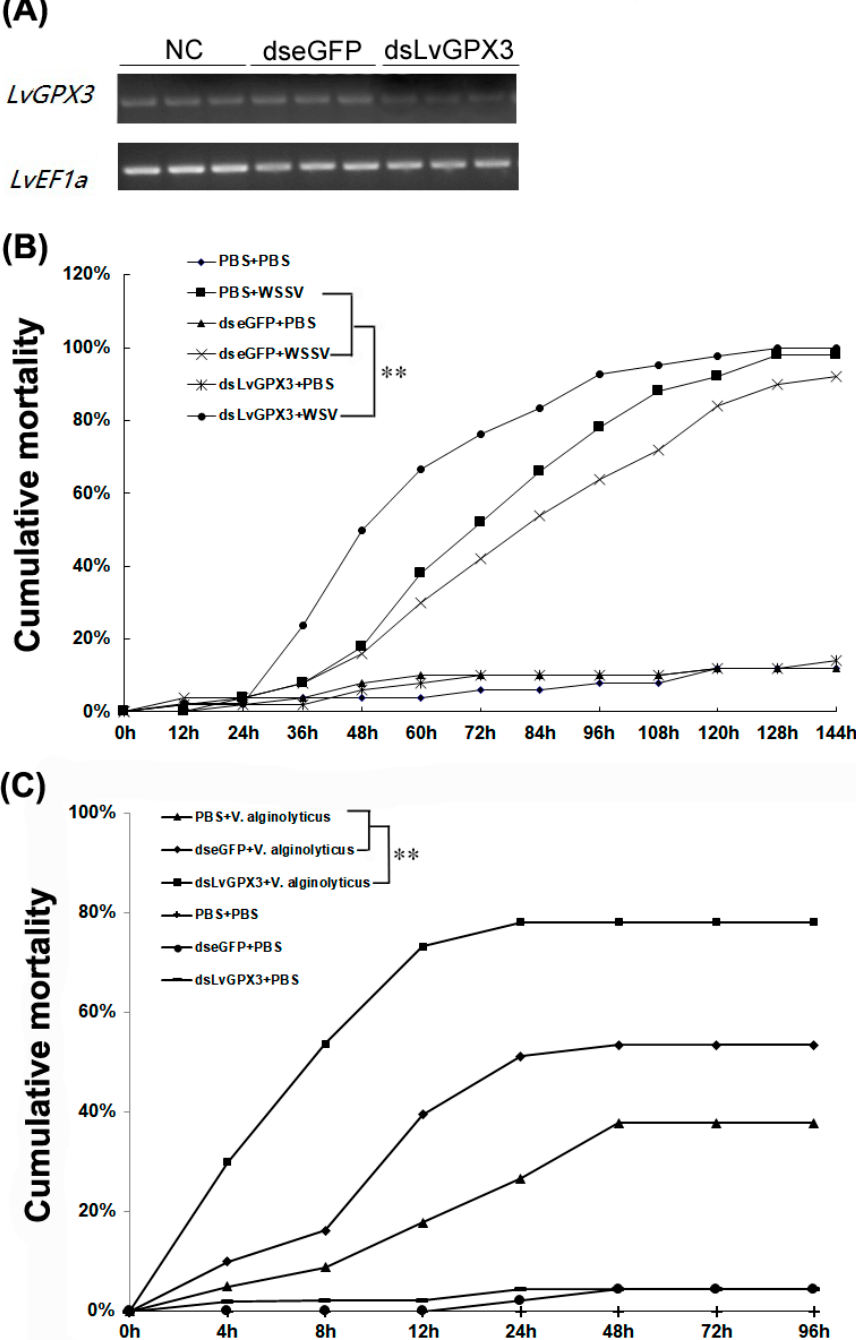
Figure 6. Cumulative mortality following treatment with dsLvGPX3 plus immune challenged.